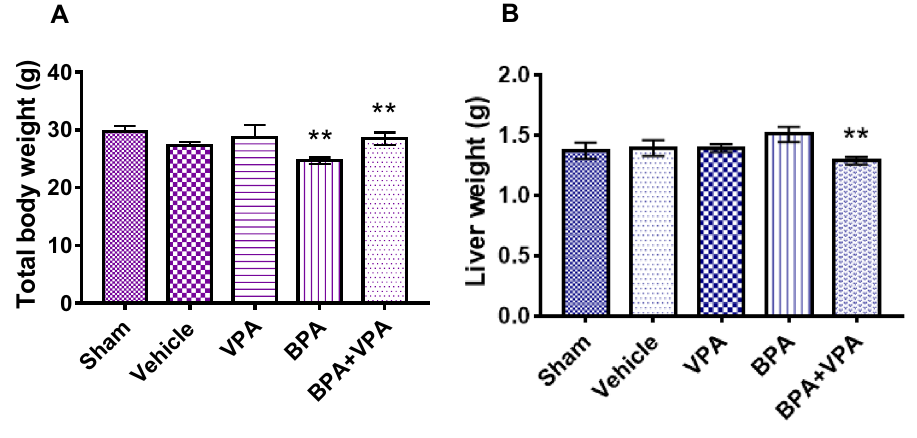
Figure 1. VPA preserved body and liver weights in BPA-exposed mice. ( A ) Quantification of the TBW. ( B ) Quantification of the liver weight. Data are represented as the mean ± SEM ( n = 6 per group). ** P < 0.01. VPA valproic acid, BPA bisphenol A, TBW total body weight, SEM standard error of the mean.